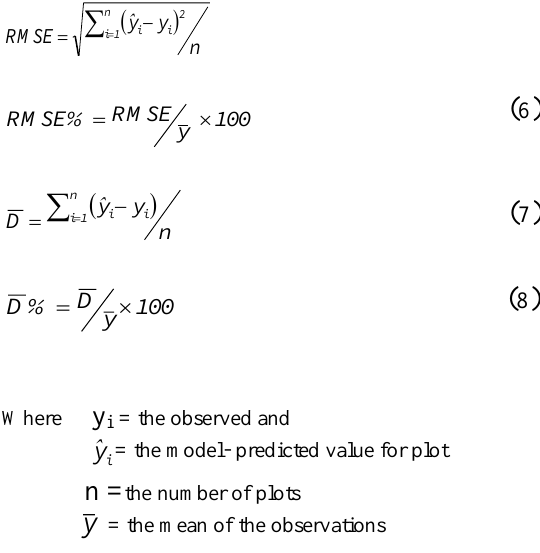
Table 1 shows the results of the evaluation criteria of the random forest algorithm with the different number of Kin estimating volume using only spectral data. The results revealed that modeling with 10 variables in each node (k=10) had a minimum of RMSE and was selected as optimal K in estimating the volume using the Pleiades data.